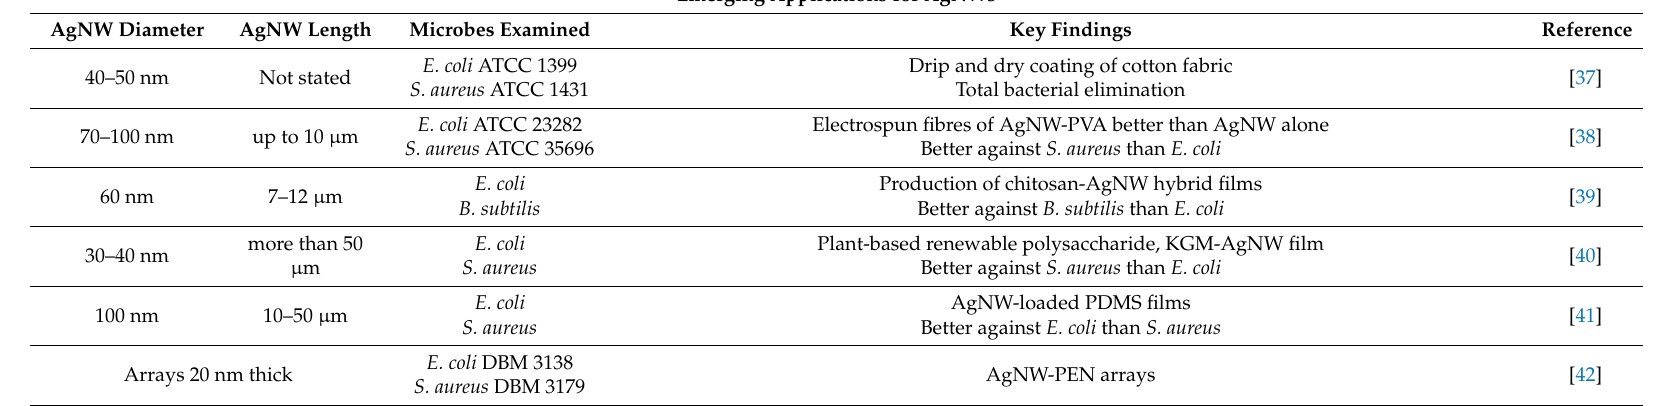
Emerging Applications for AgNWs Key Findings